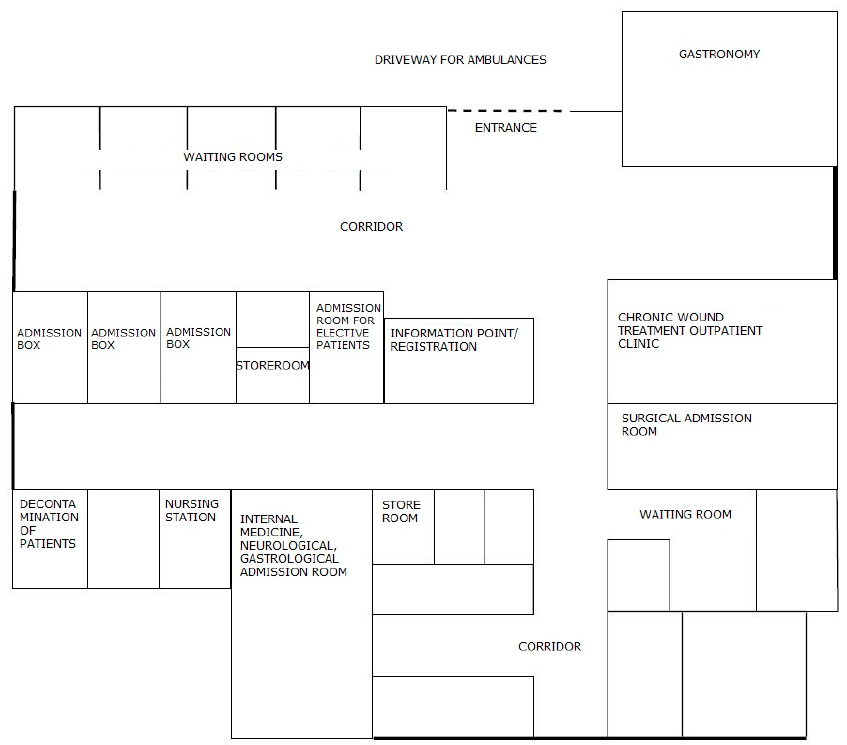
Figure 7. The scheme of the rooms in the admission room after the changes had been made. Source: own study.